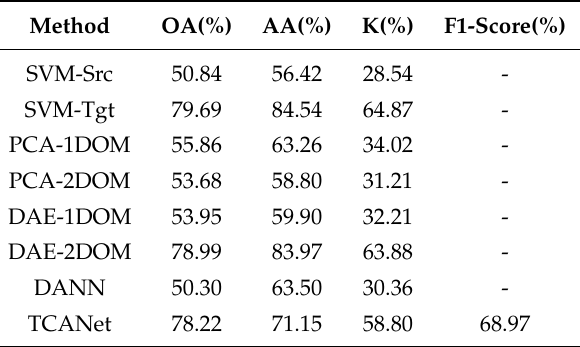
Table 7. Results for the Indiana